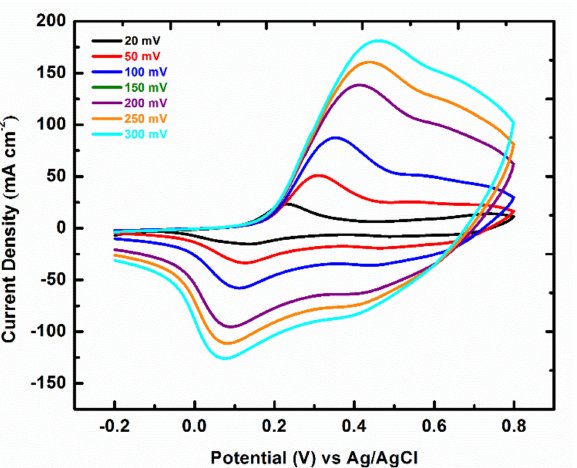
Figure 7. Cyclic voltammogram binder supported FTO-PANI in 1 M H 2 SO 4 vs Ag/AgCl (KCl sat in H 2 O) at various scan rates.